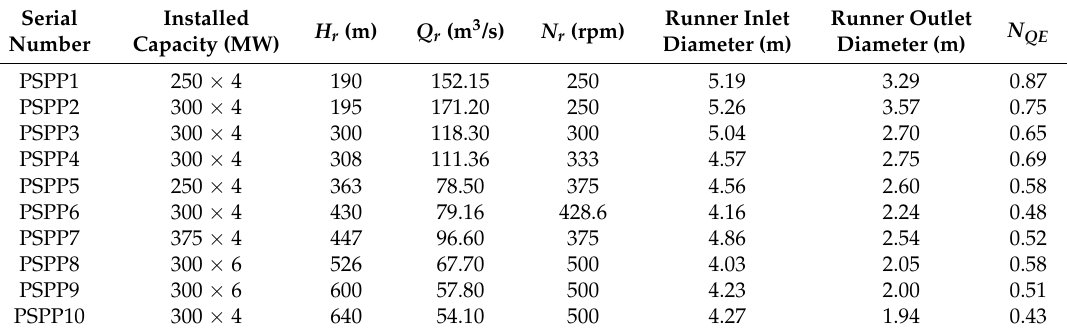
Table 1. Basic design parameters of